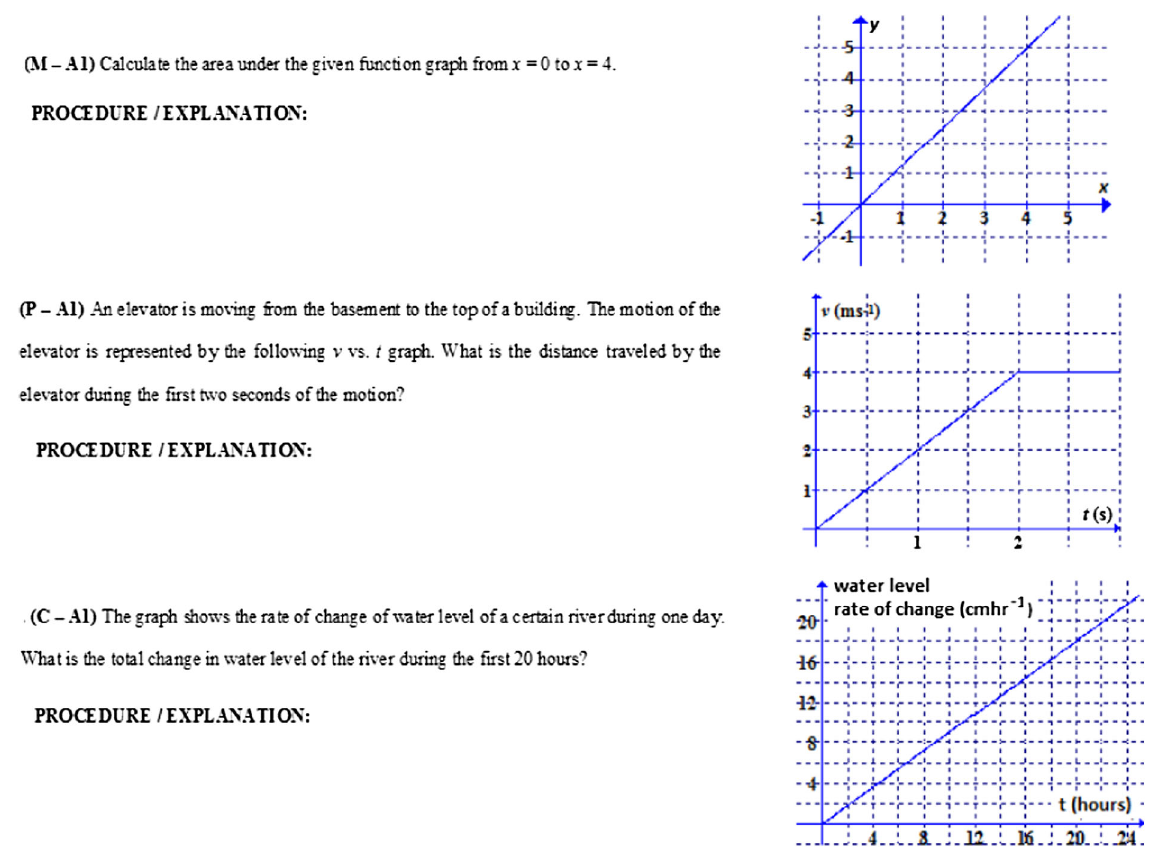
FIG. 1. An example of one set of parallel questions.